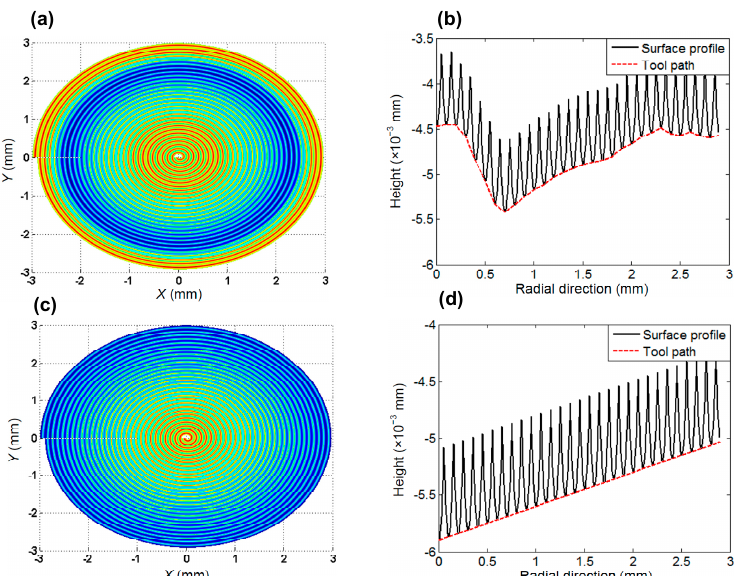
Figure 8. Influence of X-slide carriage straightness error and spindle roll error on the surface topography: ( a ) 2D surface topography when considering the influence of X-slide straightness error; ( b ) sectional view of surface topography corresponding to ( a ); ( c ) 2D surface topography when considering the influence of spindle roll error; ( d ) sectional view of surface topography corresponding to ( c ). Reproduced with permission from [94].